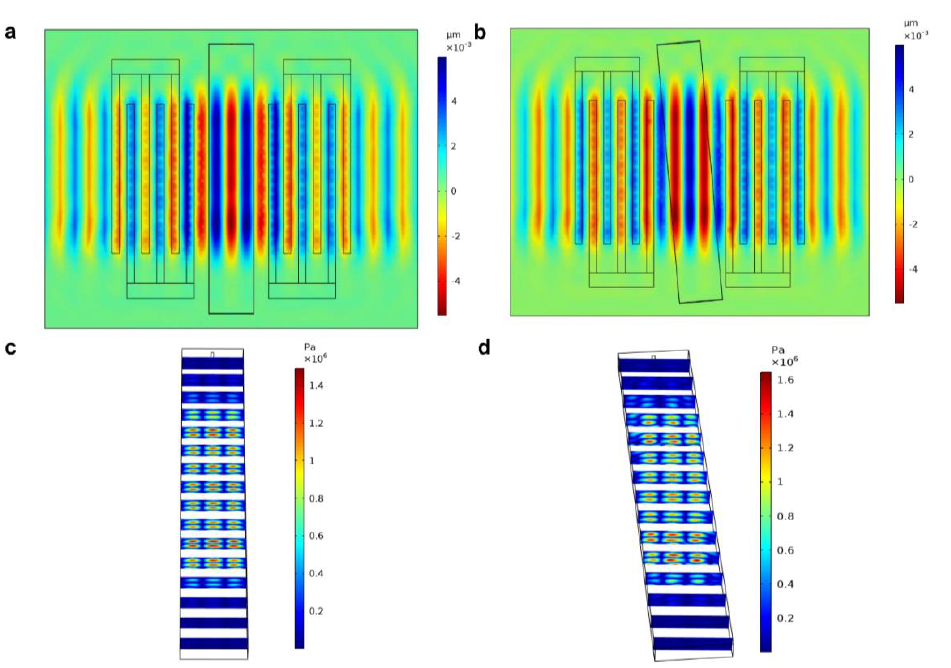
Figure 3. Mesh convergence analysis. ( a ) The computational mesh of the model. ( b ) The relative convergence value under variable mesh size, which is dependent on m .